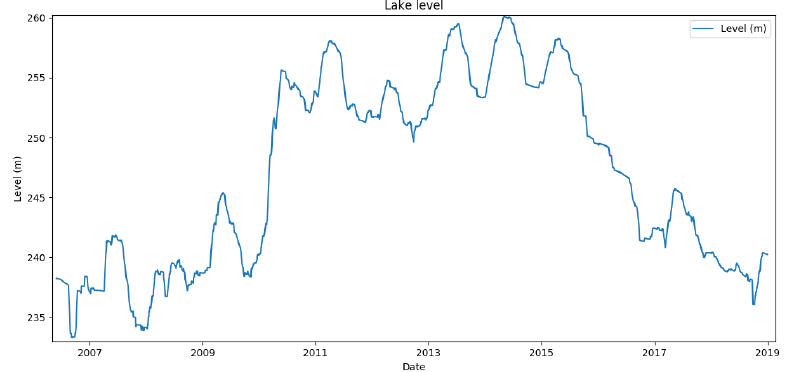
Figure 17. Lake level fluctuation between 2006 and